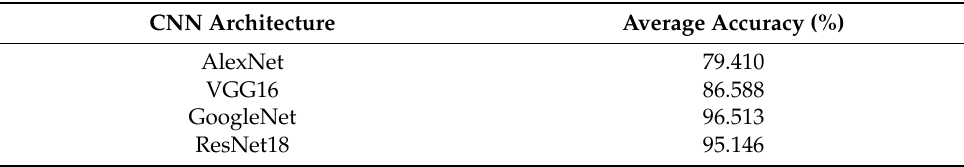
Table 10. The Average Accuracy of Pre-Trained CNN in Real-Time Trash